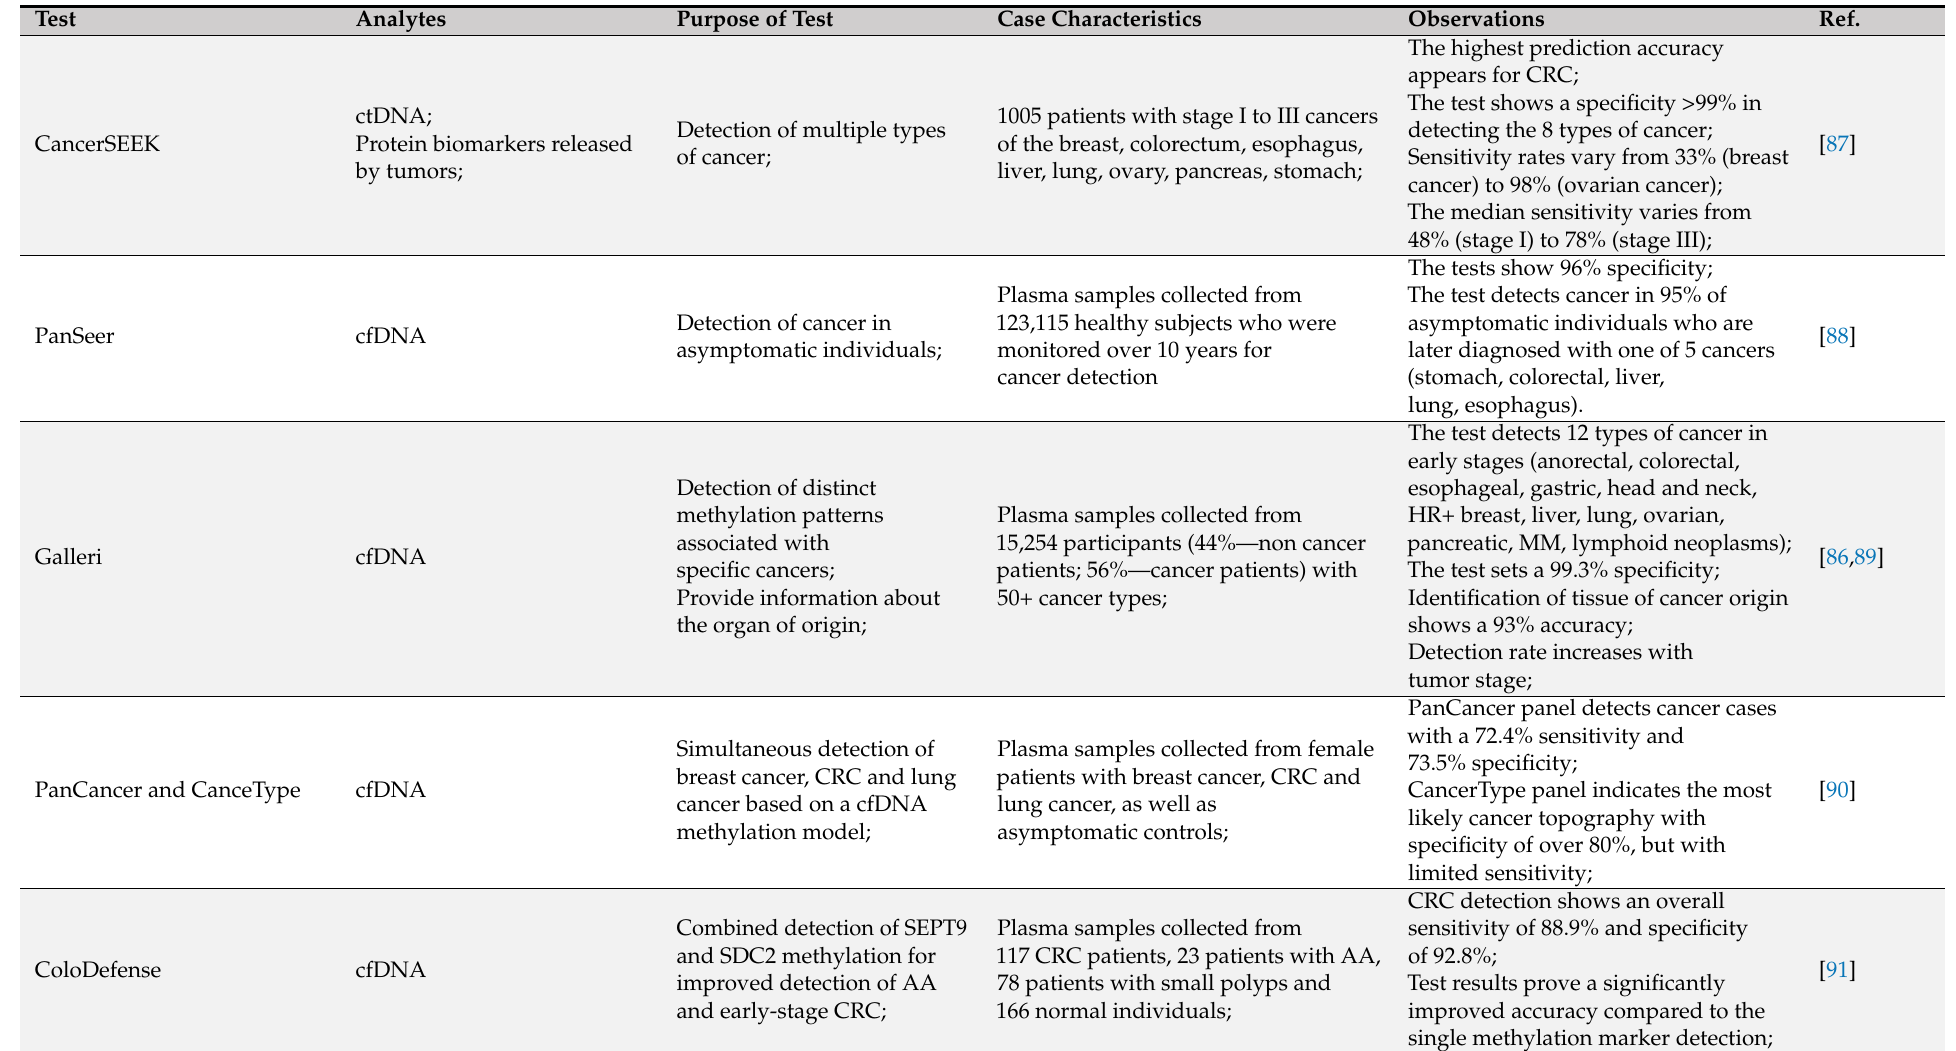
Table 2. Outline on blood-based liquid biopsy tests with confirmed validity in CRC screening and early